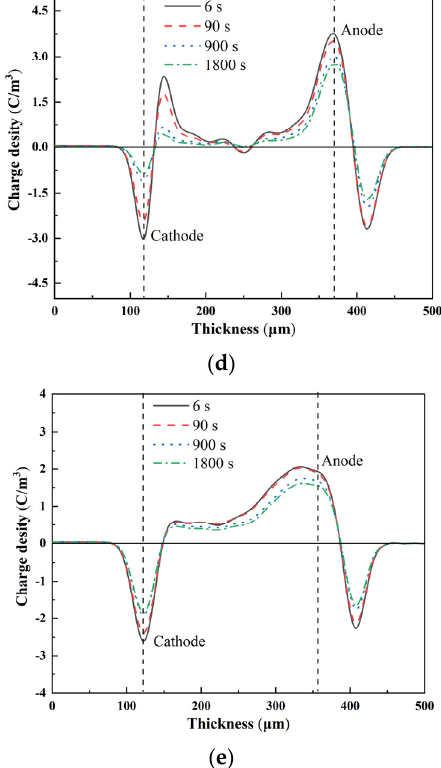
Figure 8. Space-charge distribution of pure LDPE and nanocomposite specimens with different con- tents of Al 2 O 3 -h-BN/LDPE in short circuit of 1800 s: ( a ) LDPE; ( b ) 1% (0.5%h-BN/0.5%Al 2 O 3 )/LDPE; ( c ) 2% (1.0%h-BN/1.0%Al 2 O 3 )/LDPE; ( d ) 4% (2.0%h-BN/2.0%Al 2 O 3 )/LDPE; and ( e ) 7% (3.5%h- BN/3.5%Al 2 O 3 )/LDPE.